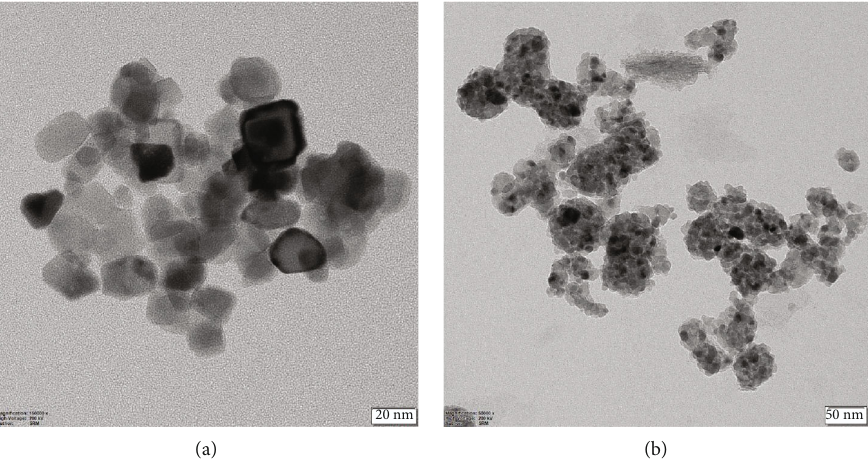
Figure 1: HRTEM image of dried nanoparticles after dispersion in water: (a) CeO